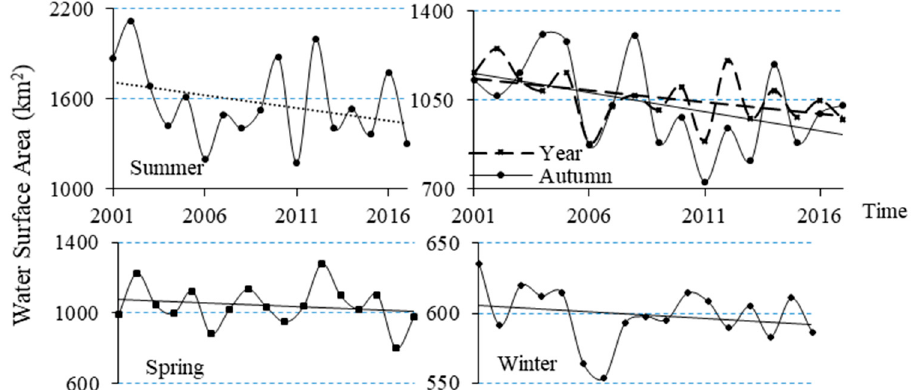
Figure 5. Seasonal and interannual changes in the water area of Dongting Lake from